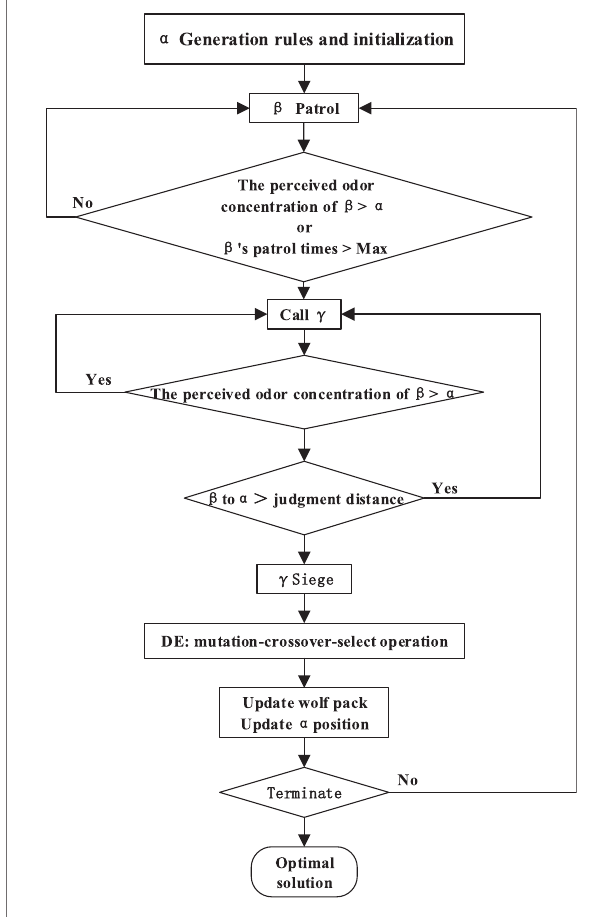
FIGURE 2 | HGWO-SVM prediction